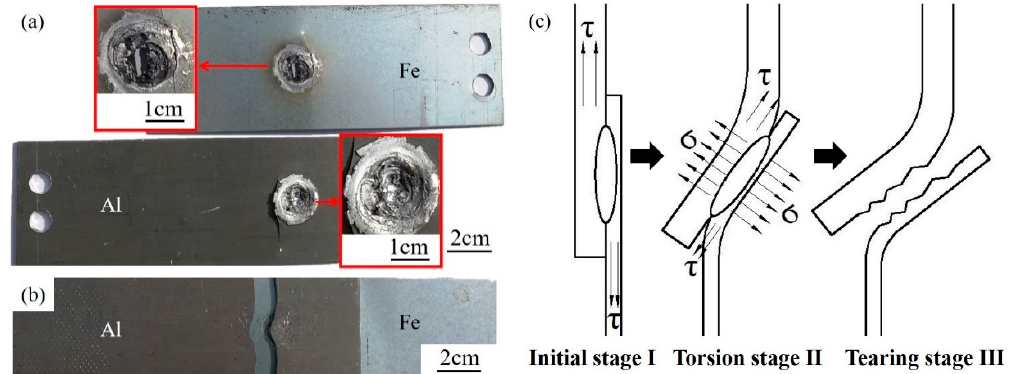
Figure 9. Macroscopic morphology ( a , b ) and diagram ( c ) of fatigue fracture of dissimilar Al/steel keyhole-free FSSW joints under asymmetric fatigue load ( a ) and under low-stress symmetric fatigue load ( b ).